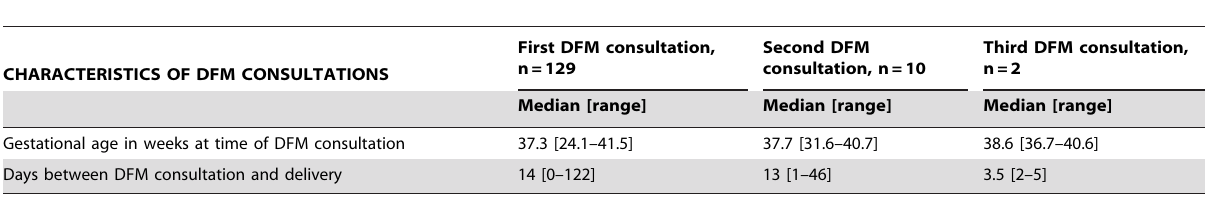
Table 4. Characteristics of consultations for DFM from 129